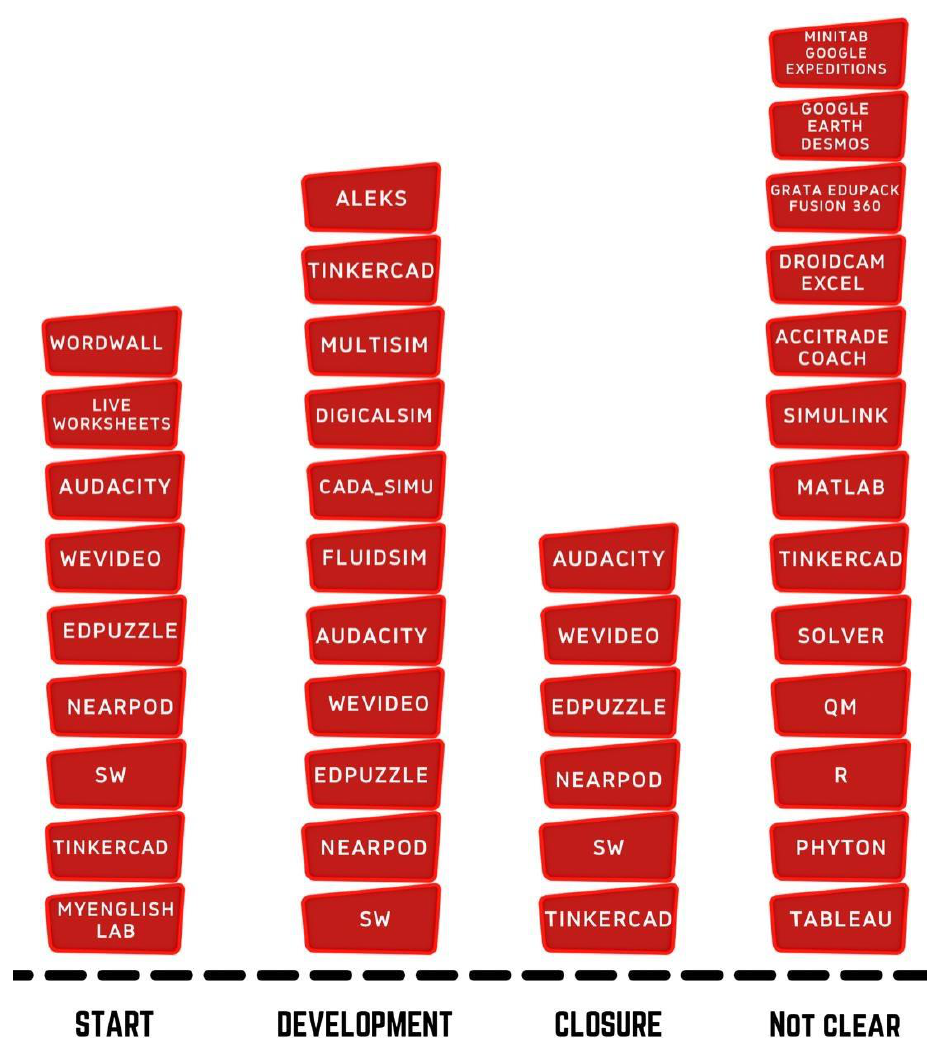
Figure 3. Apps distribution according to the moments of the formative sequence.